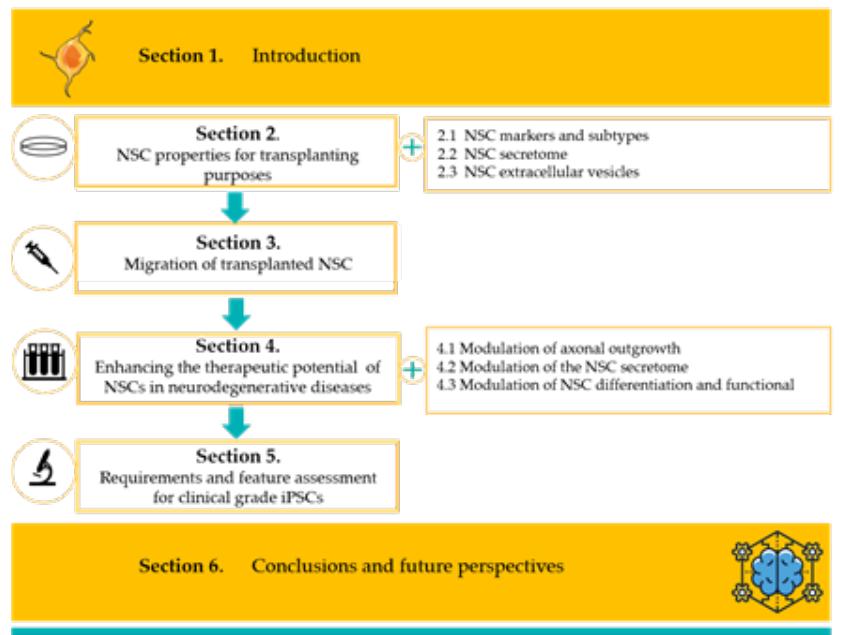
Figure 1. Summary of review’s sections. This review recapitulates some aspects of